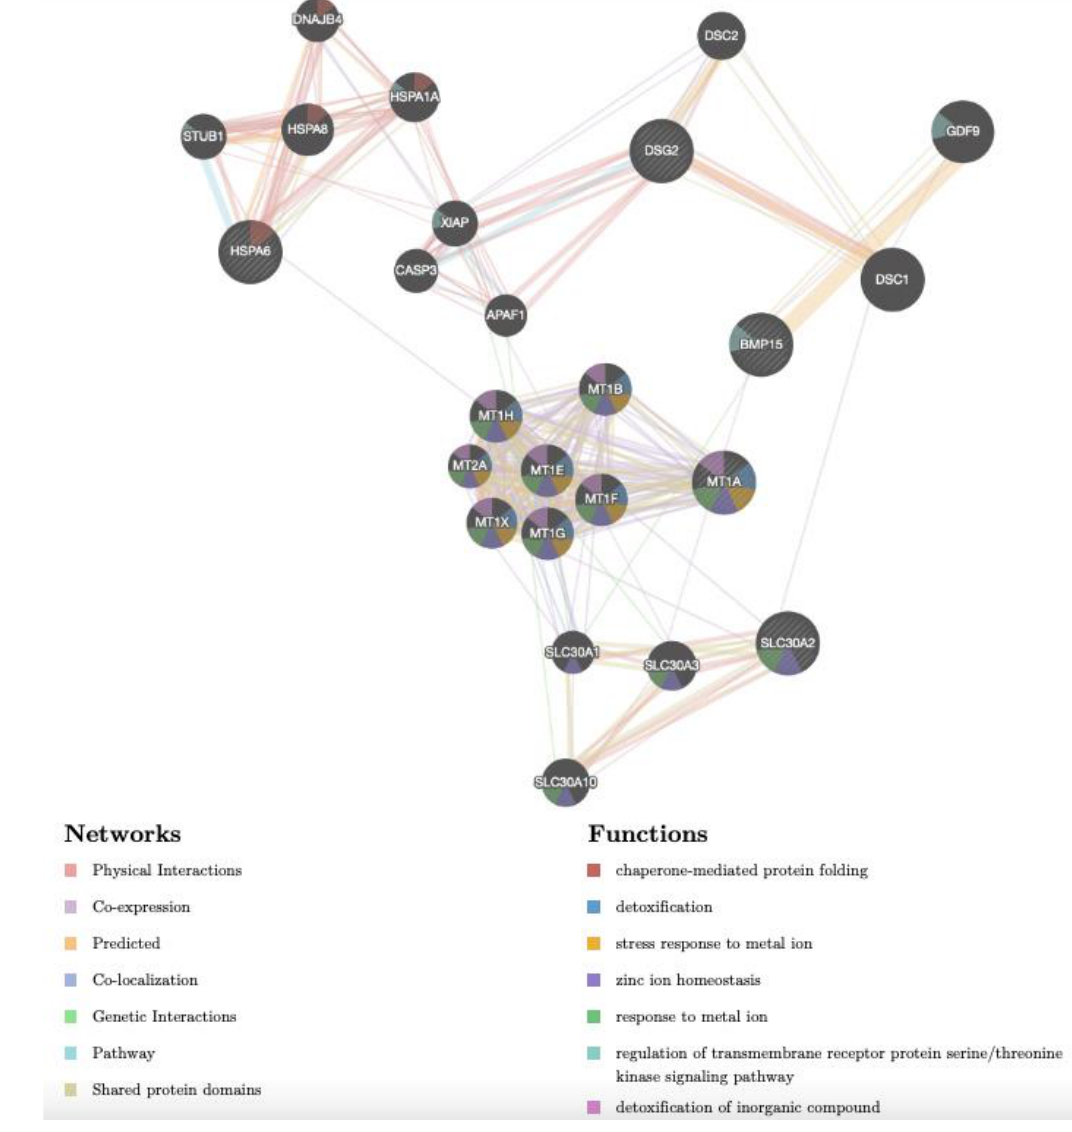
Figure 5. Gene network of DEGs (DSG2, MT1A, BMP15, SLC30A2, HSPA6), selected after tran- scriptomic analysis upon Cd treatment in CCs of prepubertal lambs and analysed by GeneMANIA (http://www.genemania.org, accessed on 14 December 2022). Differently coloured lines indicate the bioinformatics methods applied: co-expression, website prediction, pathway, physical interactions, and co-localization. The differently coloured network nodes indicate the biological functions of the set of enrichment genes.